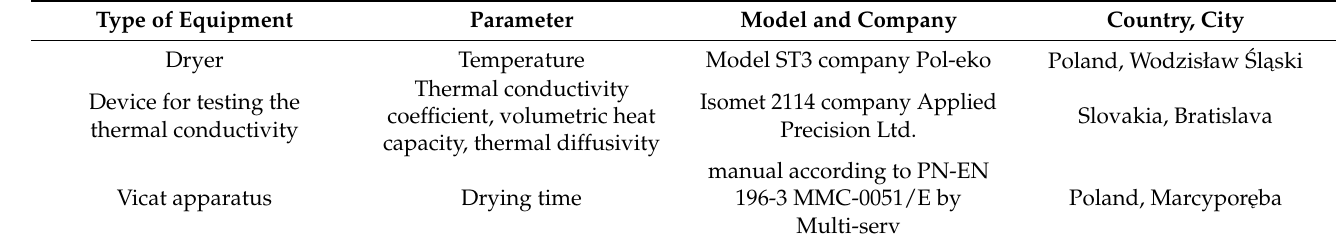
Table 3. Laboratory equipment used to perform the